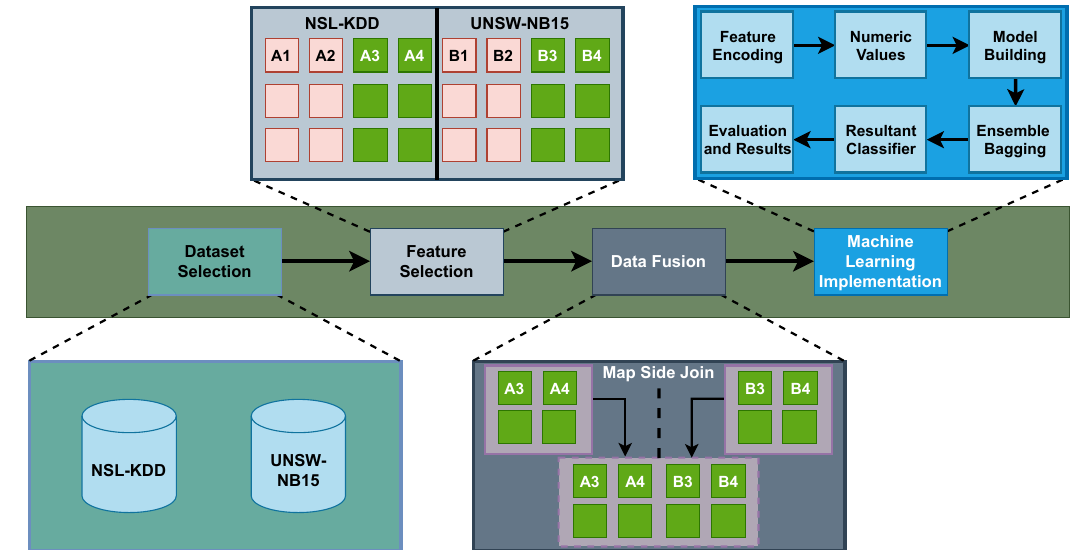
Figure 2. Working Design of Proposed